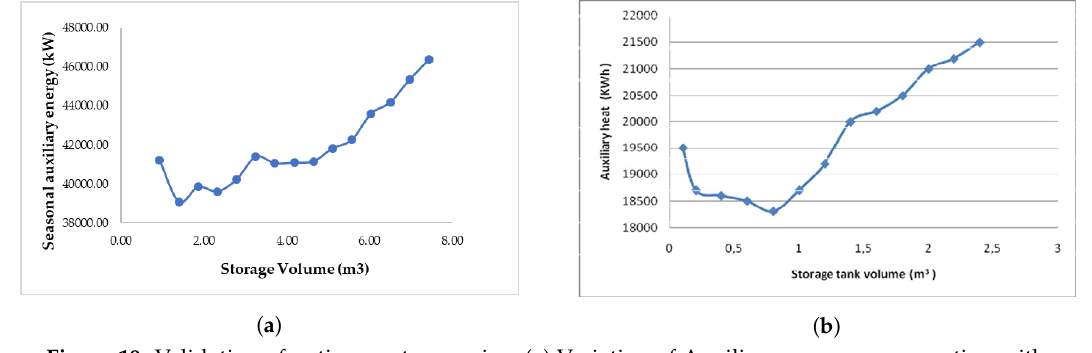
Figure 19. Validation of optimum storage size. ( a ) Variation of Auxiliary energy consumption with tank volume for climate of Pakistan. ( b ) Variation of Auxiliary energy consumption with tank volume for climate of